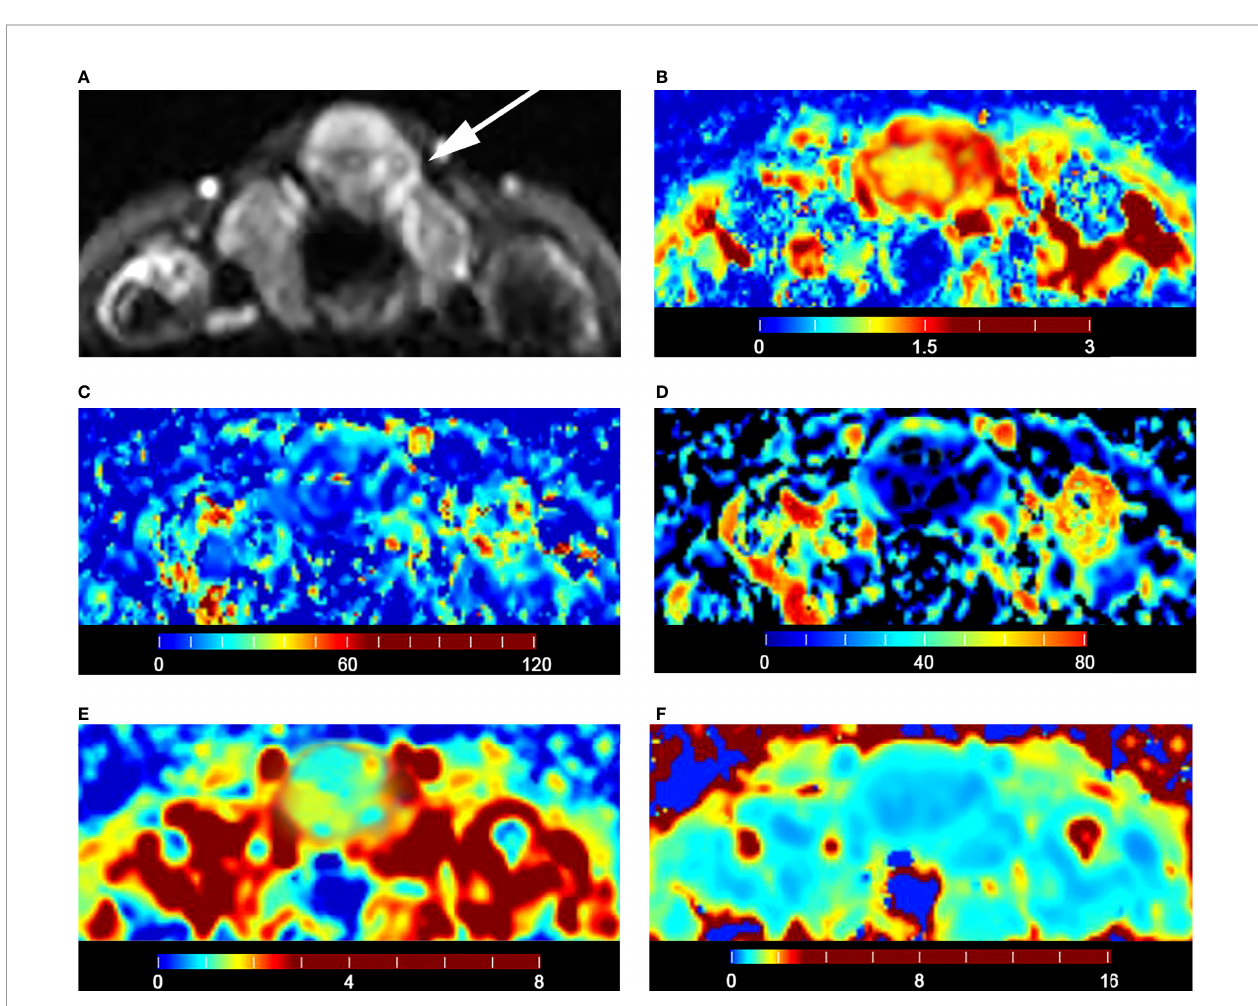
FIGURE 2 | Images of a 36-year-old female with isthmus papillary carcinoma: (A) axial diffusion image with b = 0; (B) color map of D, D value of lesion is 0.93 × 10 - 3 mm 2 /s; (C) color map of D*, D* value of lesion is 16.04 × 10 -3 mm 2 /s; (D) color map of f, f value of lesion is 14.21%; (E) color map of D 1.53 × 10 -3 mm 2 /s; (F) color map of K app , K app value of lesion is